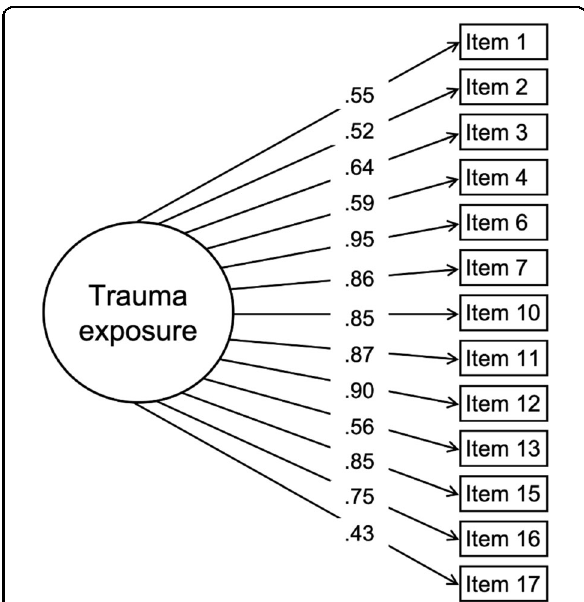
Fig. 2 Latent factor of trauma exposure. Trauma exposure was assessed using the traumatic events checklist for posttraumatic stress disorder from the Kiddie Schedule for Affective Disorders and Schizophrenia (K-SADS) 37 . As noted in Table 2, items 5, 8, 9, and 14 were excluded from the factor analysis due to extremely low endorsement. Thus, 13 items from the K-SADS traumatic events checklist were used to derive a latent variable. With trauma items de fi ned dichotomously (yes/no), a unidimensional item-factor analysis 41 was used to derive a single latent variable, which we called “ trauma exposure. ” Standardized loadings are shown.